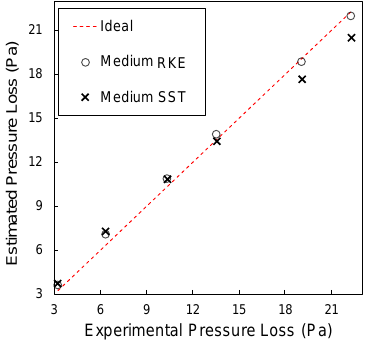
Fig. 5. CFD simulation at 1.5 m/s and 0° of inclination angle, for the three CoR evaluated.